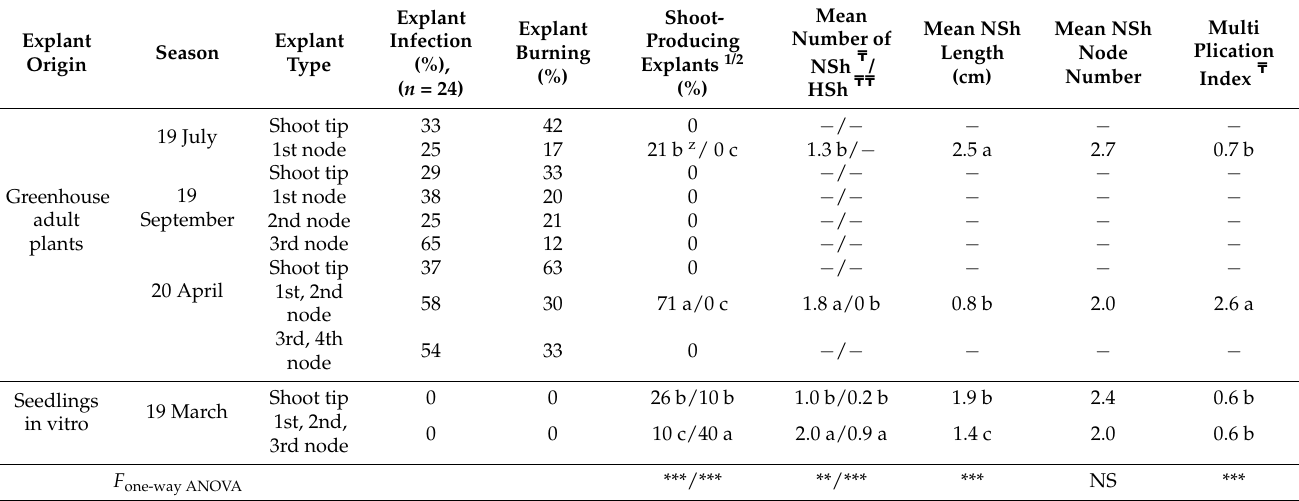
z Mean separation in columns by Student’s t , p ≤ 0.05; means followed by the same letter are not significantly different at p ≤ 0.05. NS: nonsignificant or **, *** significant at p ≤ 0.01, p ≤ 0.001, respectively, n = 7–14. Multiplication index = shoot-producing explants 1 (%) × mean shoot number ₸ × mean node number ₸ . 1 The explants produced normal and hyperhydrated shoots. 2 The explants produced hyperhydrated shoots only. ₸ NSh = normal shoot. ₸₸ HSh = hyperhydrated shoot.